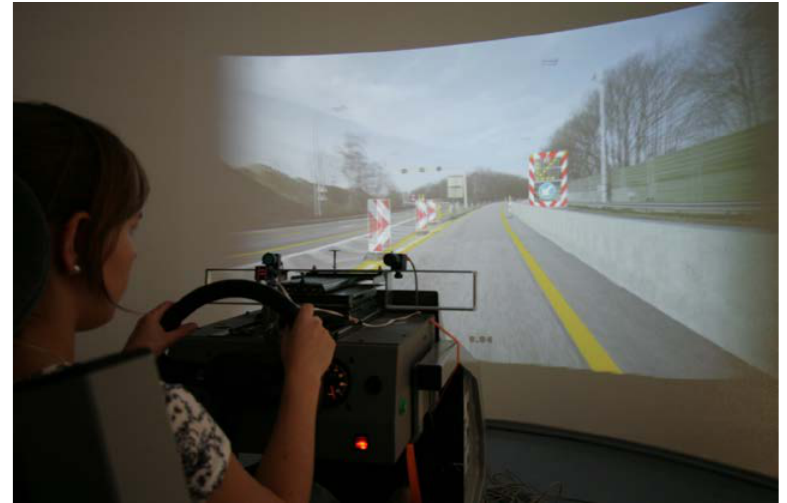
Figure 3. Traffic Sign Simulator mock-up with eye tracking